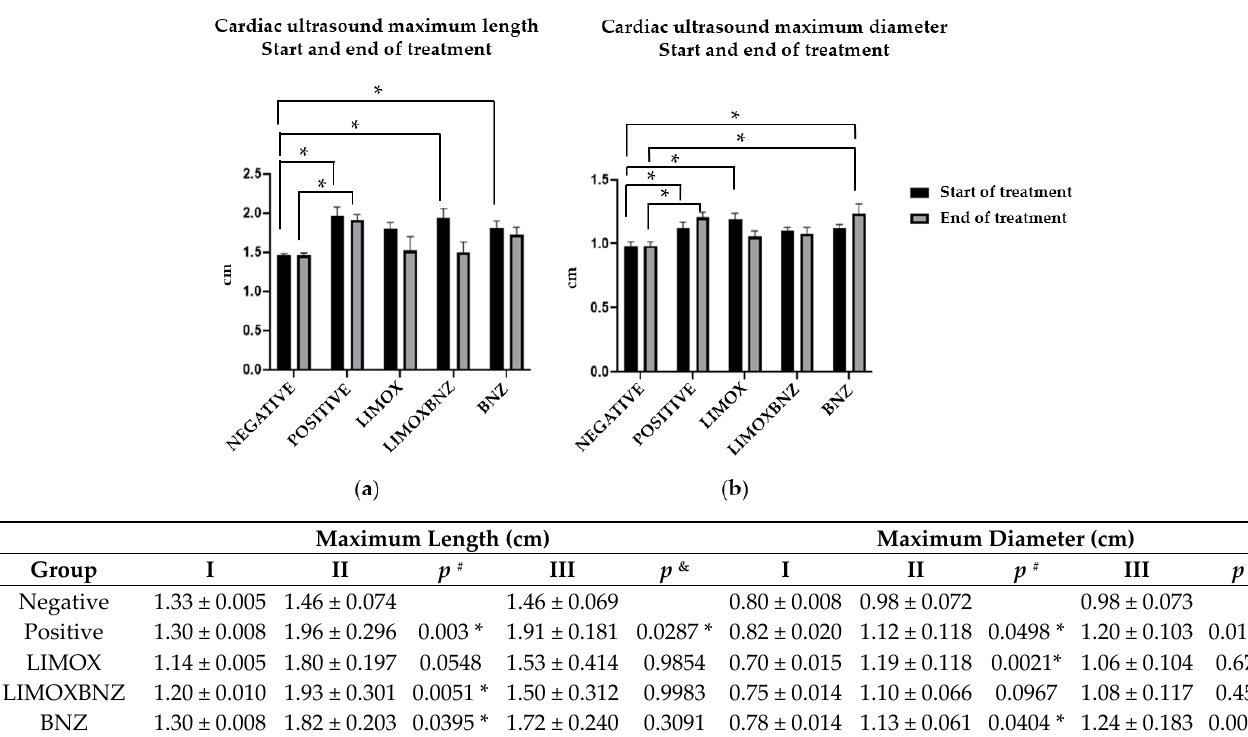
Figure 1. Echocardiography of Wistar rats infected with Trypanosoma cruzi . ( a ) Cardiac ultrasound maximum length start and end of treatment; ( b ) Cardiac ultrasound maximum diameter start and end of treatment; ( c ) Cardiac silhouette measurements via ultrasound (maximum length or ML and maximum diameter or MD) at the first (I), second (II), and third (III) echocardiography: (I) one day prior to infection; (II) at the start date of the therapies; and (III) at the end date of the treatments; p # compared with negative control measure from ultrasound II; p & compared with negative control measure from ultrasound III; * statistically significant difference at p < 0.05; Negative: untreated and uninfected animals; Positive: untreated and infected animals; LIMOX: infected animals treated with a mixture of an essential oil fraction of L. alba carvone chemotype enriched in limonene (68.9 mg/kg/day) and with added caryophyllene oxide (Sigma-Aldrich) (70 mg/kg/day); LIMOXBNZ: infected animals treated with LIMOX plus benznidazole (7.9 mg/kg/day); BNZ: infected animals treated with benznidazole (100 mg/kg/day). Data are representative of six independent experiments and values are expressed in mean ± SEM.